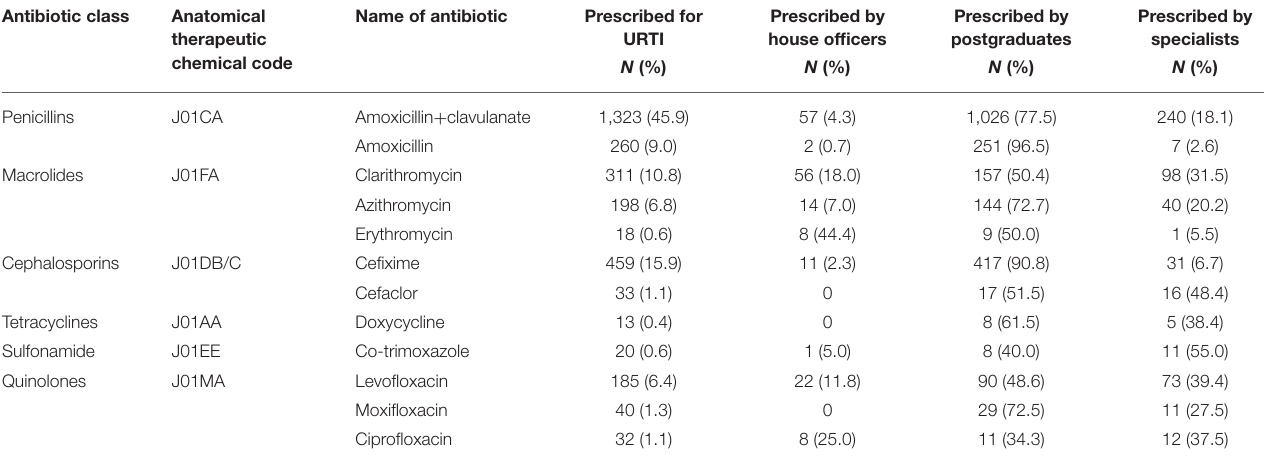
TABLE 2 | Choice of antibiotics prescribed for upper respiratory tract infections. Antibiotic